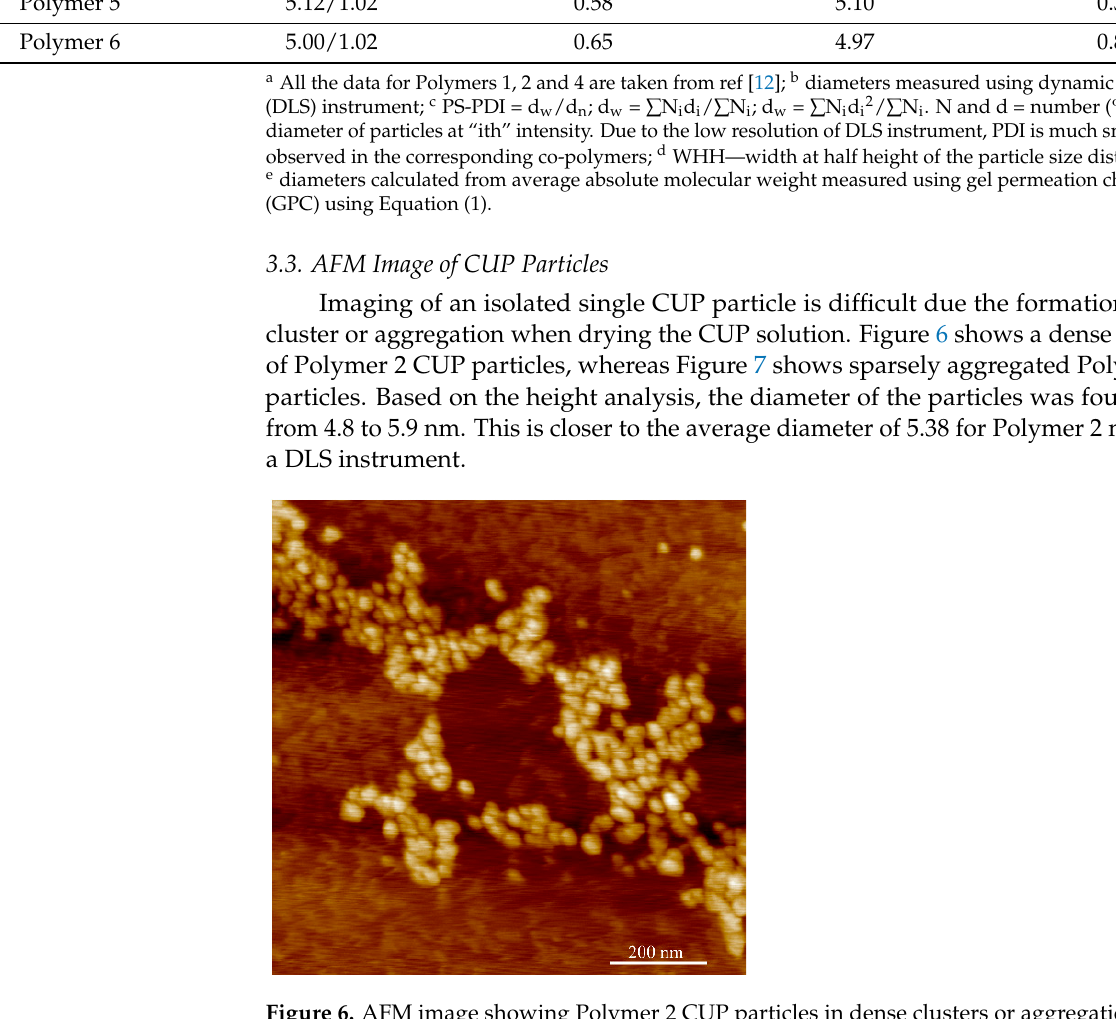
Figure 7. AFM image showing sparsely clustered or aggregated Polymer 2 CUP particles (left) and the height (nm—y axis) and width (nm—x axis) of the profile of the analyzed particles (A–D). 3.4. Charge Density of the CUP Particle The charge density ρ v —i.e., the number of charges per unit area (nm 2 ) on the CUP surface—can be calculated using equation 2, where n and m are the number of hydropho- bic monomers 1 and 2 for each unit of hydrophilic monomer in a repeat unit, and are also mentioned as a monomer ratio (e.g., n:1 of MMA:MAA) in Table 3; M W is the molecular weight of the CUP; M H 1 and M H 2 are the molecular weights of hydrophobic monomers 1